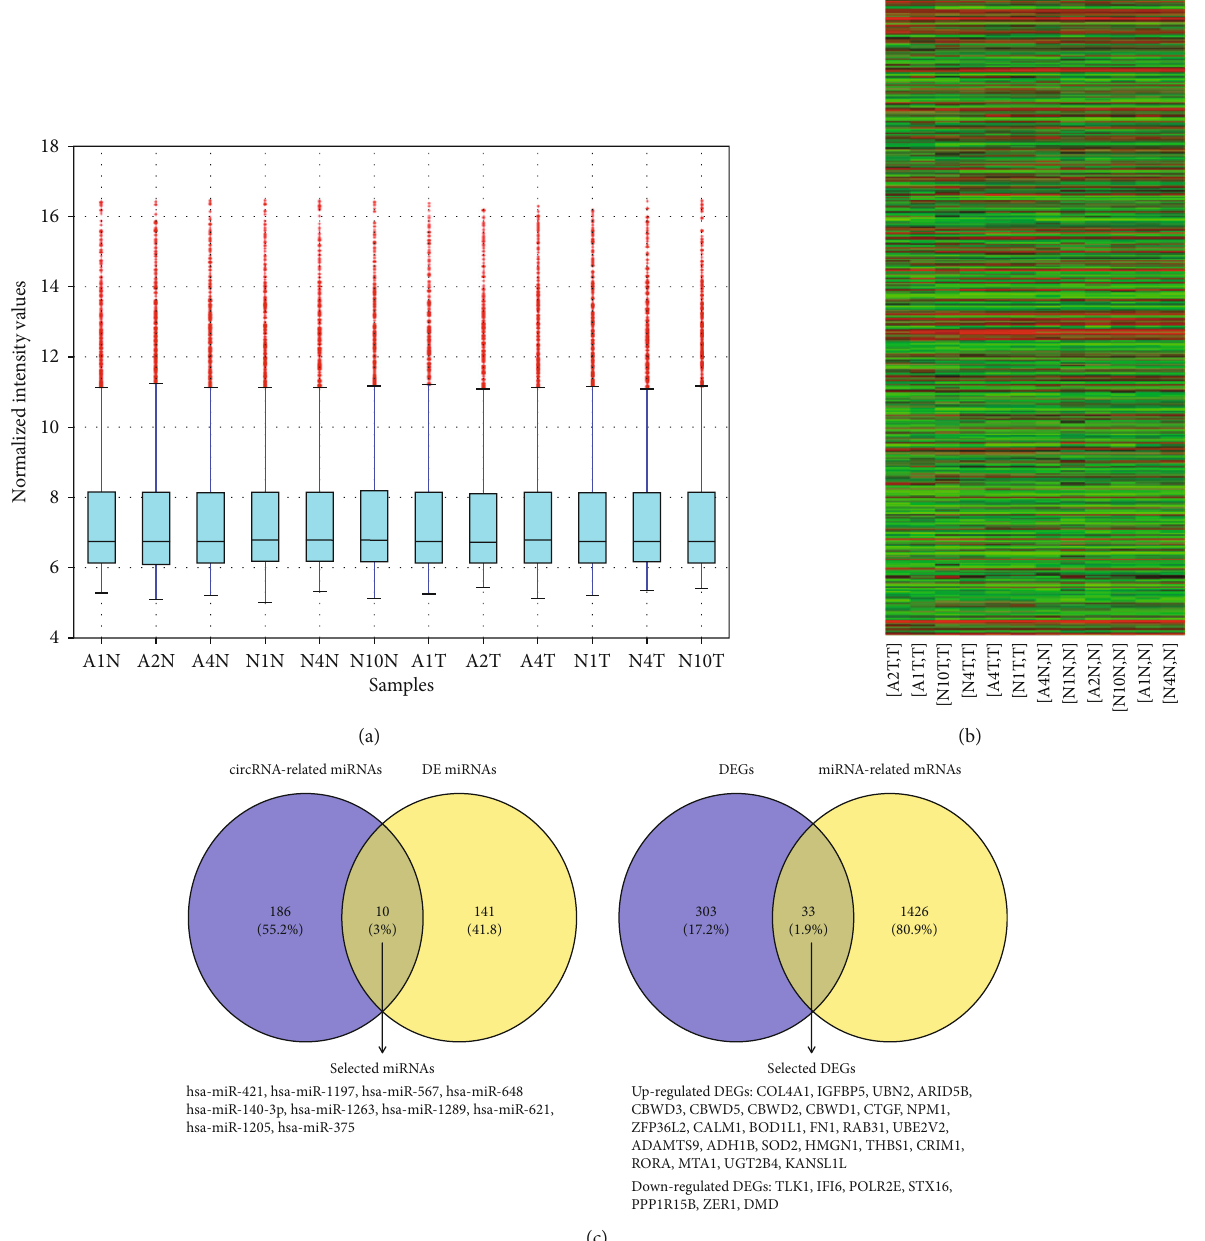
Figure 2: DE circRNAs in tumor tissues and adjacent normal tissues from GC patients, screening DE miRNAs and DE mRNAs, and visualization of the circRNA-miRNA-mRNA regulatory network. (a) The box plot shows variations in circRNA expression. (b) The heat map shows DE circRNAs in 6 tumors (T) and 6 normal (N) tissues. Gene expression pro fi les are shown in rows. “ Red ” suggests a high relative expression, and “ green ” indicates low relative expression. (c) Based on DE miRNAs and circRNA-related miRNAs, Venn diagrams were used to select the overlapping 10 miRNAs; based on DE mRNAs and miRNA-related mRNAs, Venn diagrams were used to select the overlapping 33